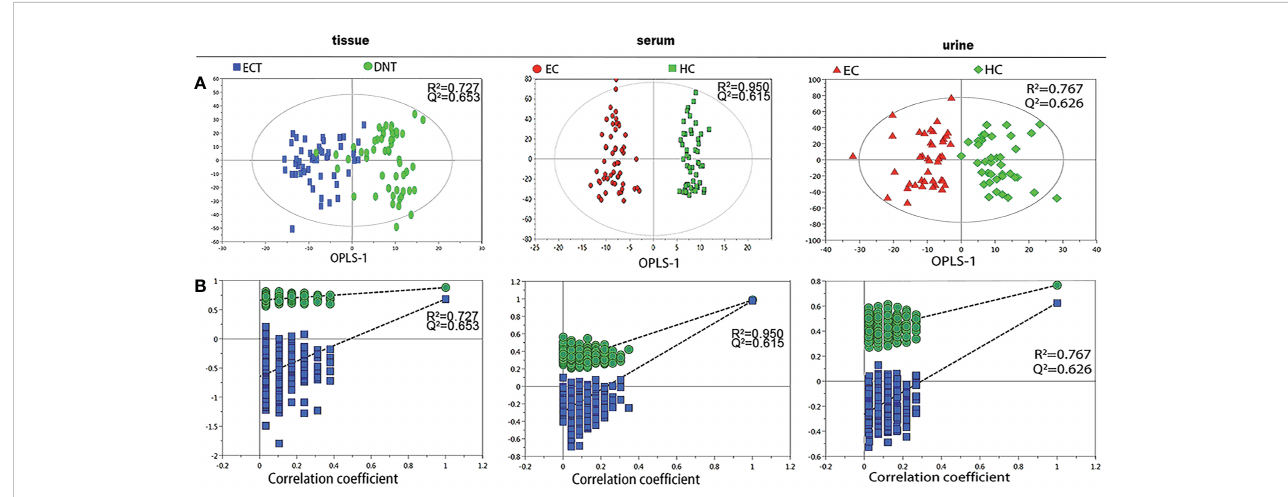
FIGURE 2 Pattern recognition analysis of 1 H-NMR tissue, serum and urine spectra between ESCC and their respective controls. (A) OPLS-DA scores plot depicting the difference between experimental groups; (B) Statistical validation of the corresponding OPLS-DA model by permutation analysis (400 times).